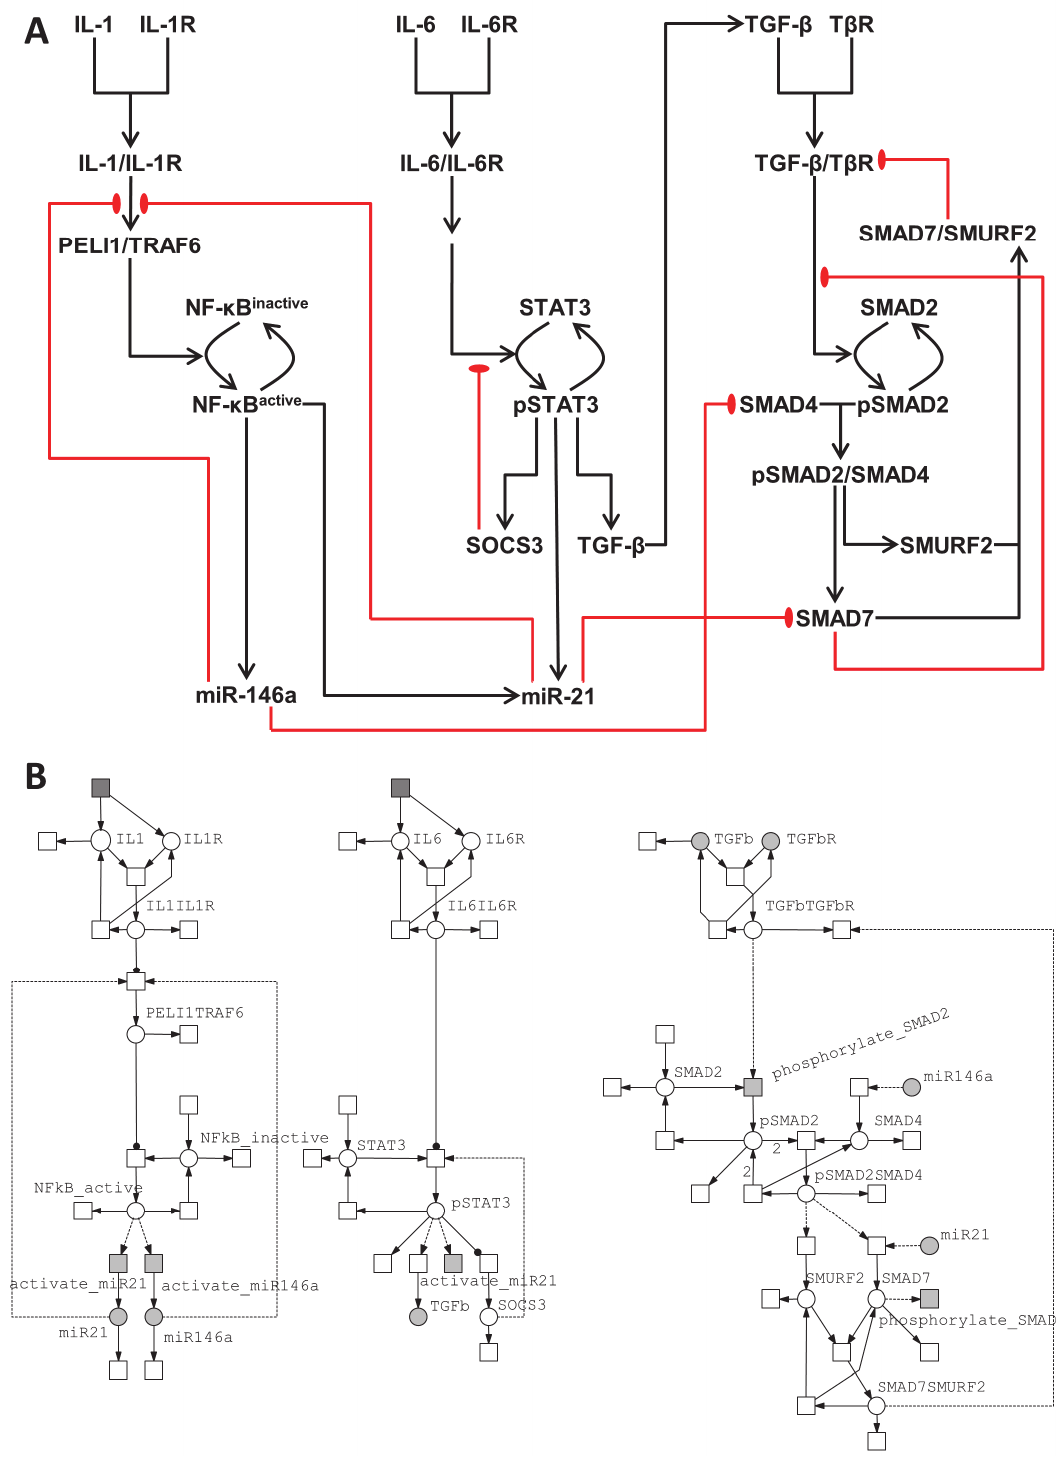
Figure A3. Schematic ( A ) and Petri net ( B ) representations of the model simulated in Figure 5, excluding the fibrotic gene (FG)